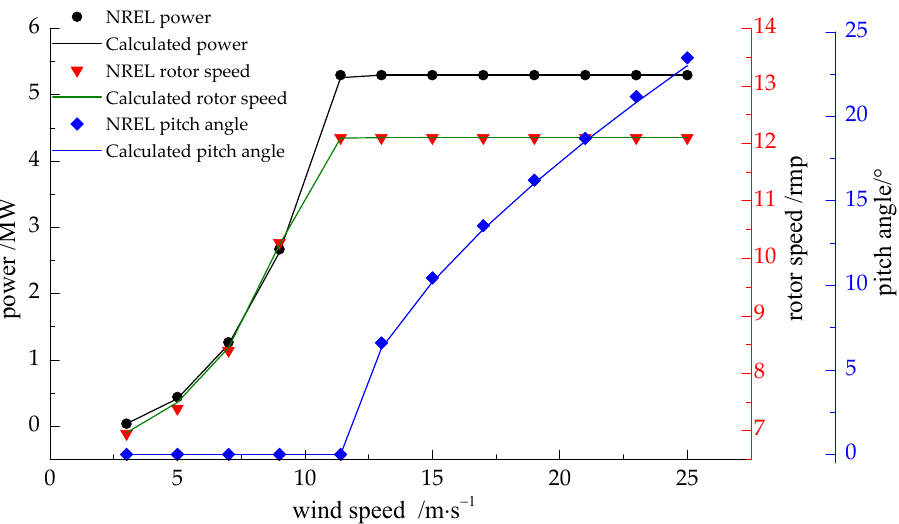
Figure 8. The power of the wind rotor, rotor speed, and blade-pitch angle accounting for the coupling of the control system.